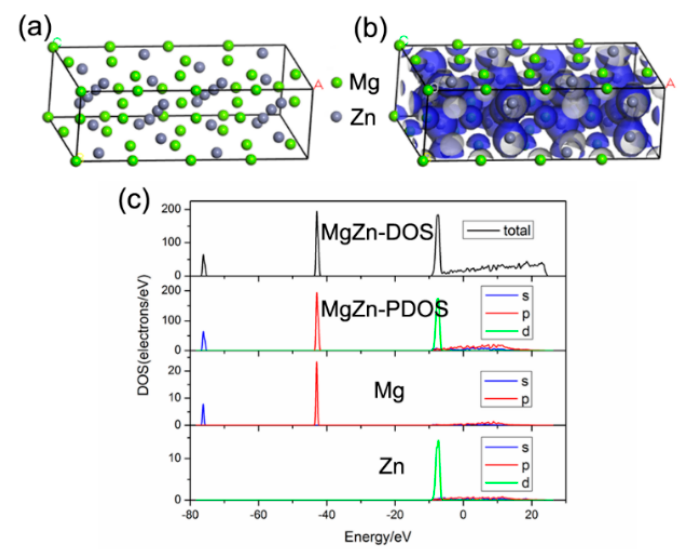
Figure 5. First-principles calculation results of Cu 2 Mg: ( a ) Unit cell model; ( b ) Electron density map; ( c ) State density maps.